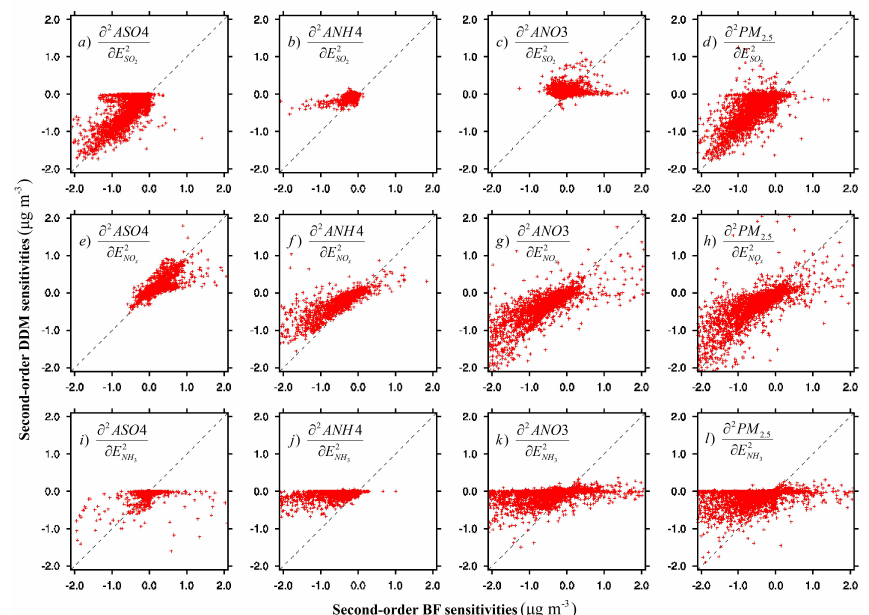
Fig. 6. Comparison of second-order sensitivities of sulfate, ammonium, nitrate, and PM 2 . 5 to SO 2 , NO x , and NH 3 calculated by HDDM- 3D/PM and BF at surface layer on 2 January 2004. ASO4, ANH4, and ANO3 denote aerosol sulfate, aerosol ammonium, and aerosol nitrate, respectively. Each plot represents one sensitivity coefficient that is labeled on the upper left of the plot. The dashed line is the one-to-one line indicating perfect